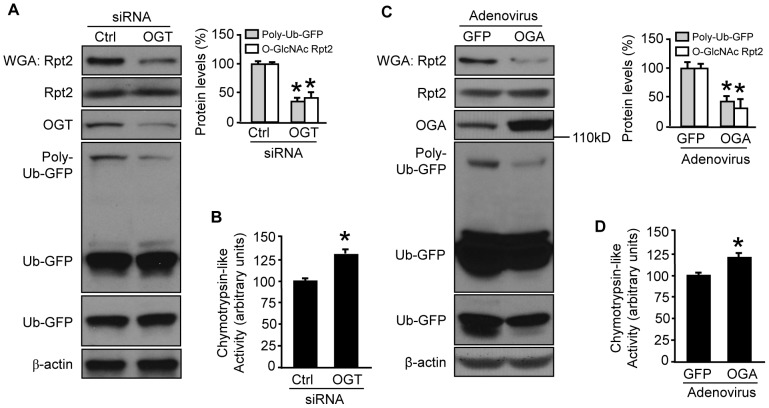
Overexpression of OGA mimics the effects of OGT knockdown by siRNA on 26S proteasomes.(A) UbG76V-GFP-expressing HUVEC were transfected either with control or OGA siRNA and cell lysates were subjected to Western blot to detect reporter protein levels and Rpt2 O-GlcNAcylation. (B) chymotrypsin-like activity in siRNA treated cells. (C) Adenoviral overexpression of OGA, not GFP, decreased both the levels of reporter protein and Rpt2 O-GlcNAcylation. (D) chymotrypsin-like activity in adenovirus infected cells. The blots shown were representative of 3 independent experiments with similar results. * represents p<0.05 vs the control (n = 3). An overlaid portion (less exposure) of each whole blot indicating Ub-GFP is presented. Ctrl, control (scrambled) siRNA; OGA, O-GlcNAcase; OGT, O-GlcNAc transferase; Ub-GFP, ubiquitin-green fluorescent protein; WGA, wheat germ agglutinin.